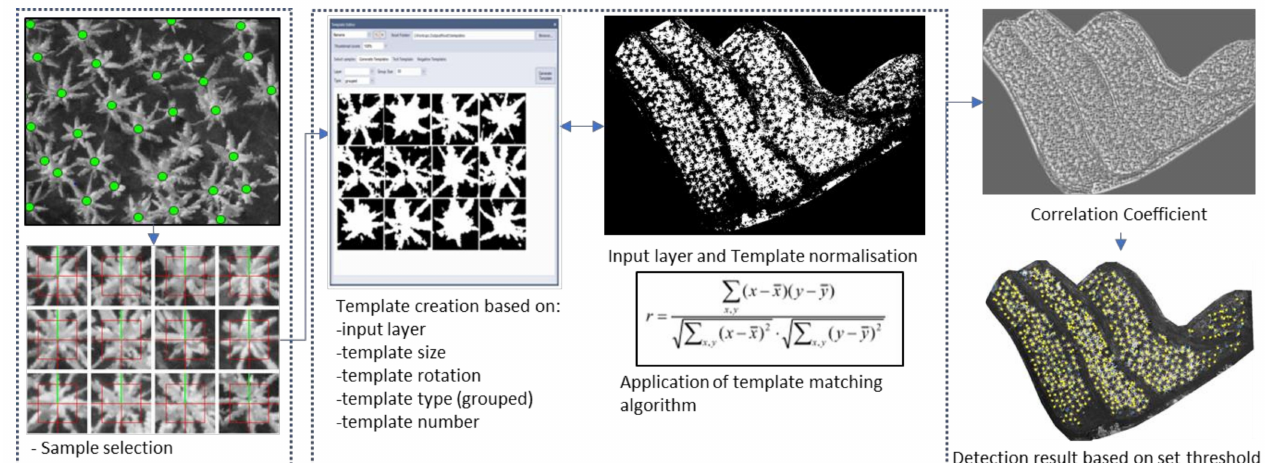
Figure 6. Overview of workflow for template matching (TM) within eCognition Developer software for the classification of individual banana